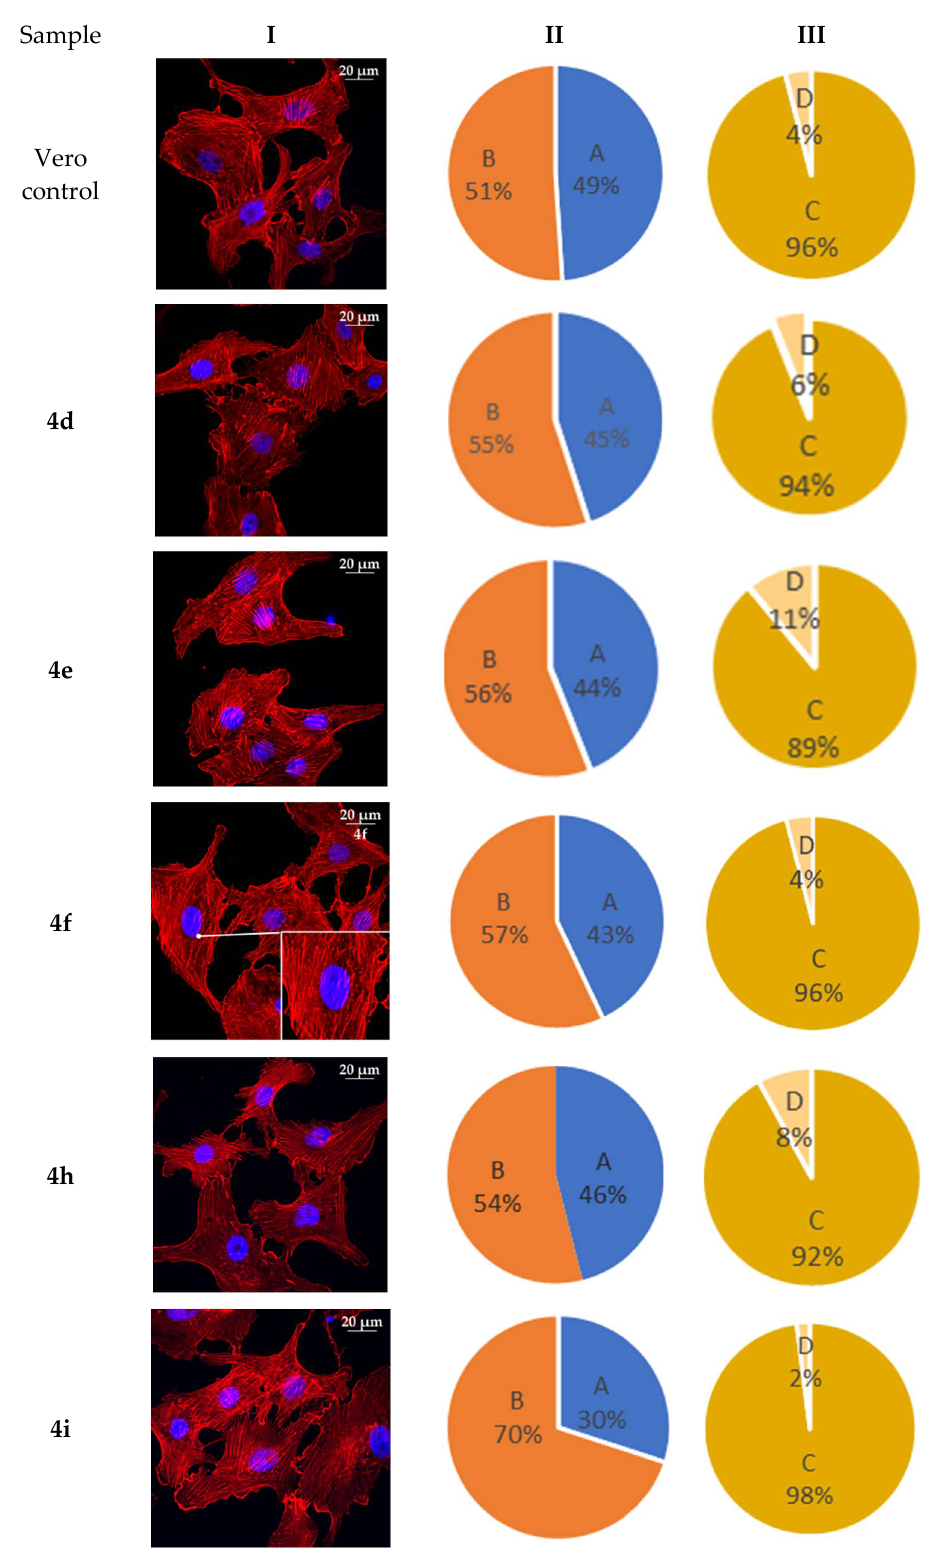
Figure 16. State of actin cytoskeleton of Vero cells after treatment with 3-azaspiro[bicyclo[3.1.0]hexane-2,5′-pyrimidines] 4d , 4e , 4f , 4h , and 4i . I: Images demonstrate the different stages of cell actin cytoskeleton. II: Pie charts demonstrate percentage of cells with filopodia-like deformations (A) and without filopodia-like deformations (B). III: Pie charts demonstrate percentage of cells with normal stress fibers (C) and disassembled stress fibers (D).